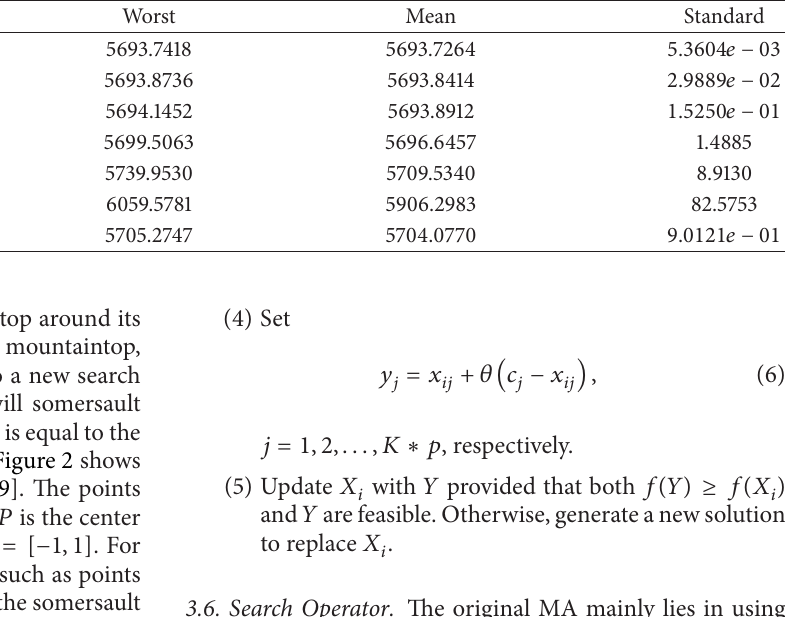
Table 12: Results obtained by the algorithms for 20 different runs on CMC